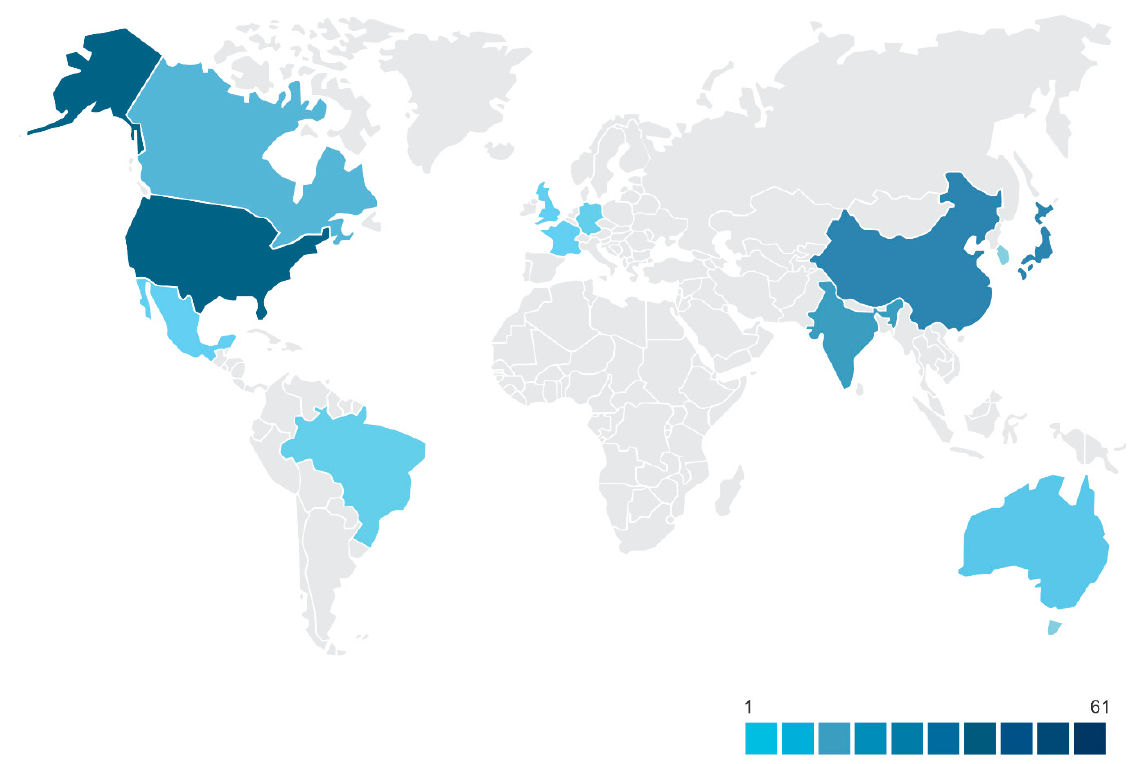
Figure 4. Patents issued on the use of silver nanoparticles in dentistry by country of publication.